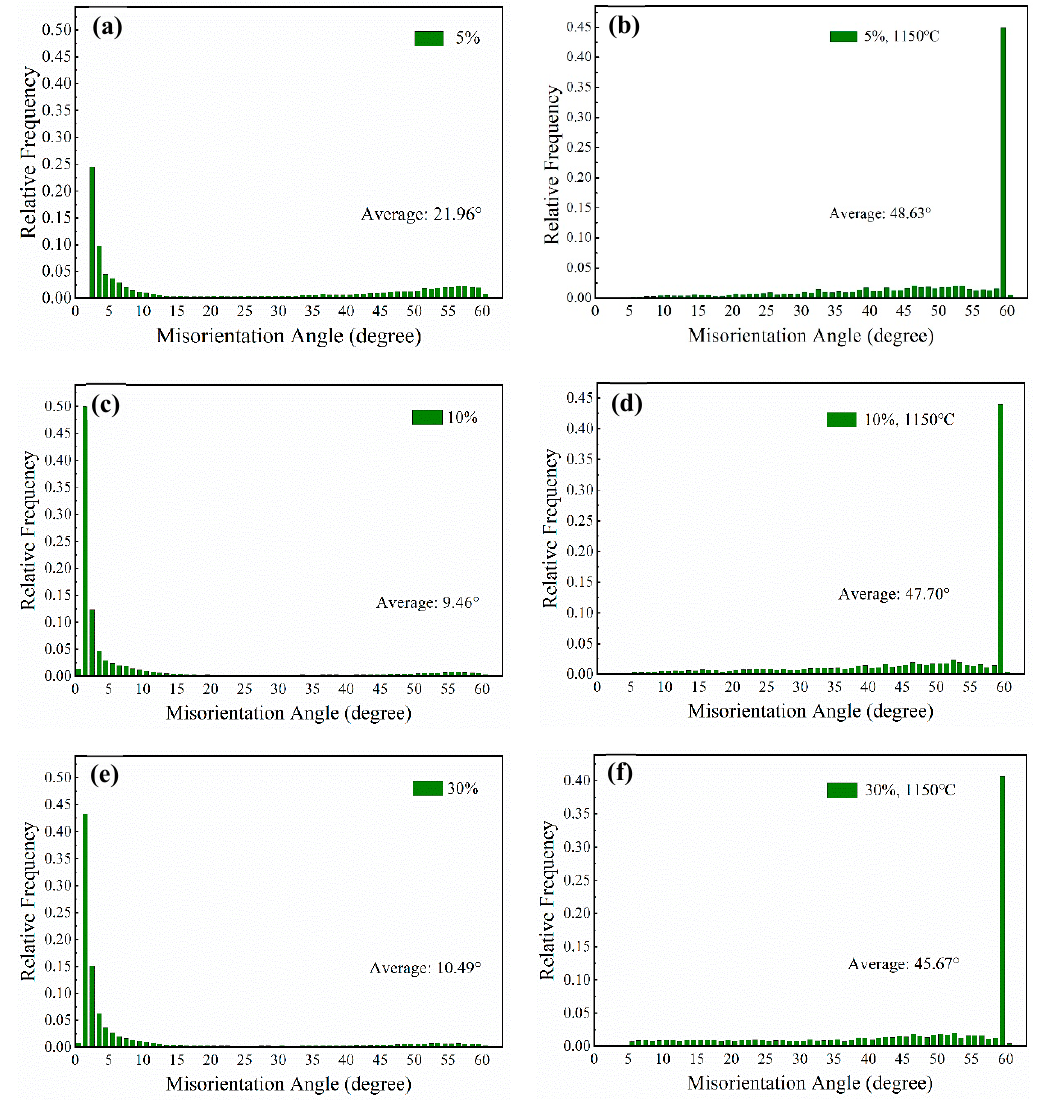
Figure 4. Misorientation angle distributions of the samples reduced by ( a ) 5%, ( c ) 10% and ( e ) 30% and then annealed at 1150 °C for 30 min after cold rolling ( b, d, f ), respectively.